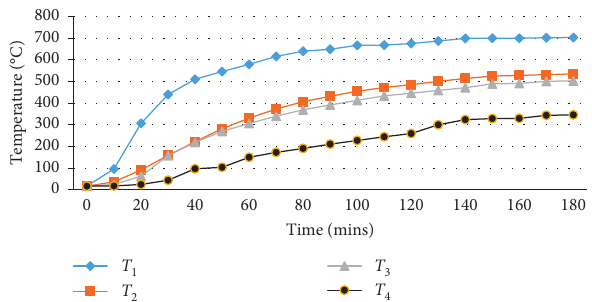
Figure 3: Plot of temperature versus time.